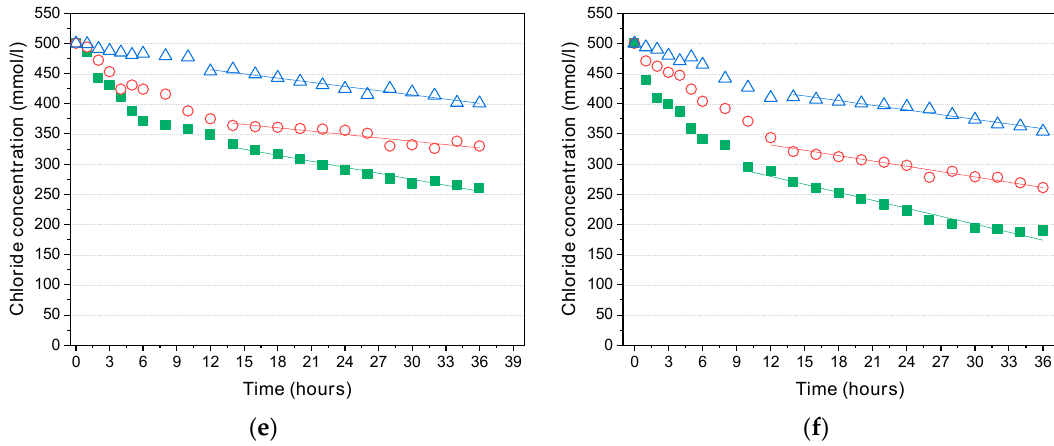
Figure 8. Chloride concentration drop in the upstream cell: ( a ) ordinary Portland cement (OPC), uncracked; ( b ) OPC, 0.3 mm crack; ( c ) SH-A, uncracked; ( d ) SH-A, 0.3 mm crack; ( e ) SH-B, uncracked; ( f ) SH-B, 0.3 mm crack.